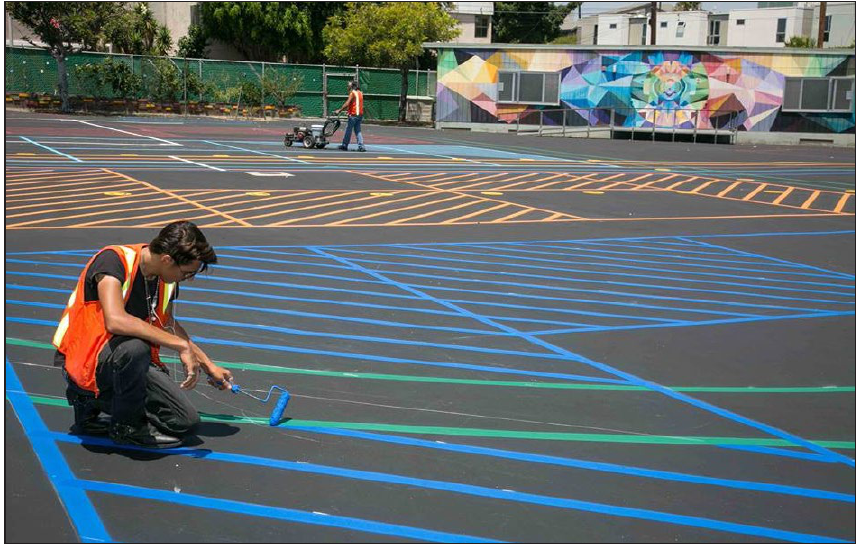
Figure 32: Iris Anna Regn with Otis Creative Action, Made for Kids , Asphalt Paint, 2015 (Photo by Allison